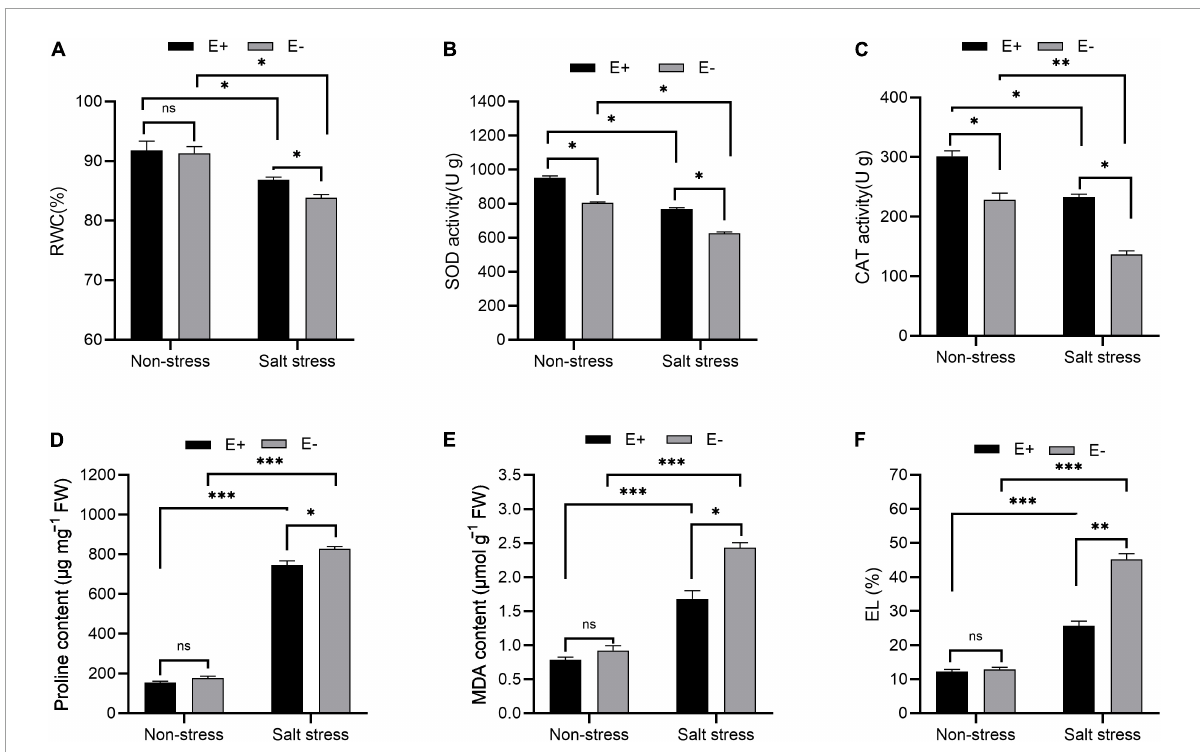
FIGURE2 Physiological response. Relative water content (RWC) (A) , superoxide dismutase (SOD) activity (B) , catalase (CAT) activity (C) , proline content (D) , malonaldehyde (MDA) content (E) and electrolyte leakage (EL) (F) of bermudagrass with inoculated and uninoculated plants under salt stress. Bars denote means ± SE of four treatment. “Non-stress” represents bermudagrass grown without NaCl condition; “Salt stress” represents bermudagrass under 250 mM salt conditions. “E + ” represents the infection of Enterobacter ludwigii i , “E − ” represents the absence of E. ludwigii. “ ∗ ,” “ ∗∗ ”, “ ∗∗∗ ” indicate significant differences at P < 0.05, P < 0.01, and P < 0.001, respectively, and “ns” represents no significant